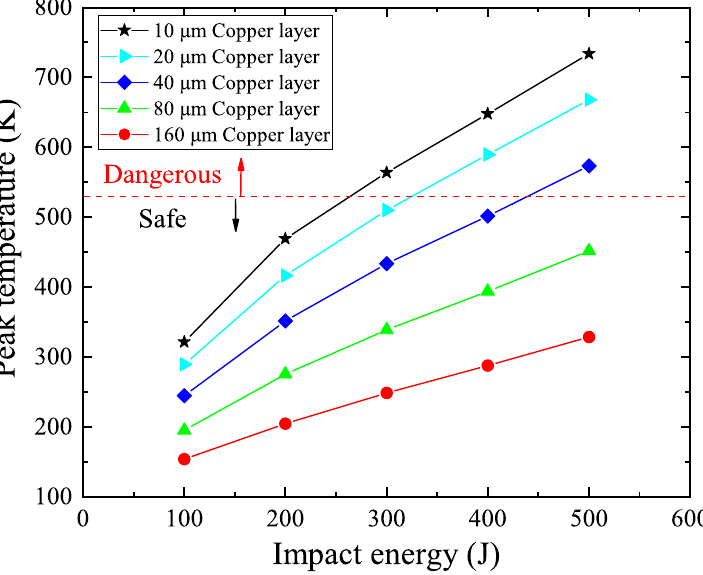
stabilizers act as thermal sink and contribute to an enthalpy increase.